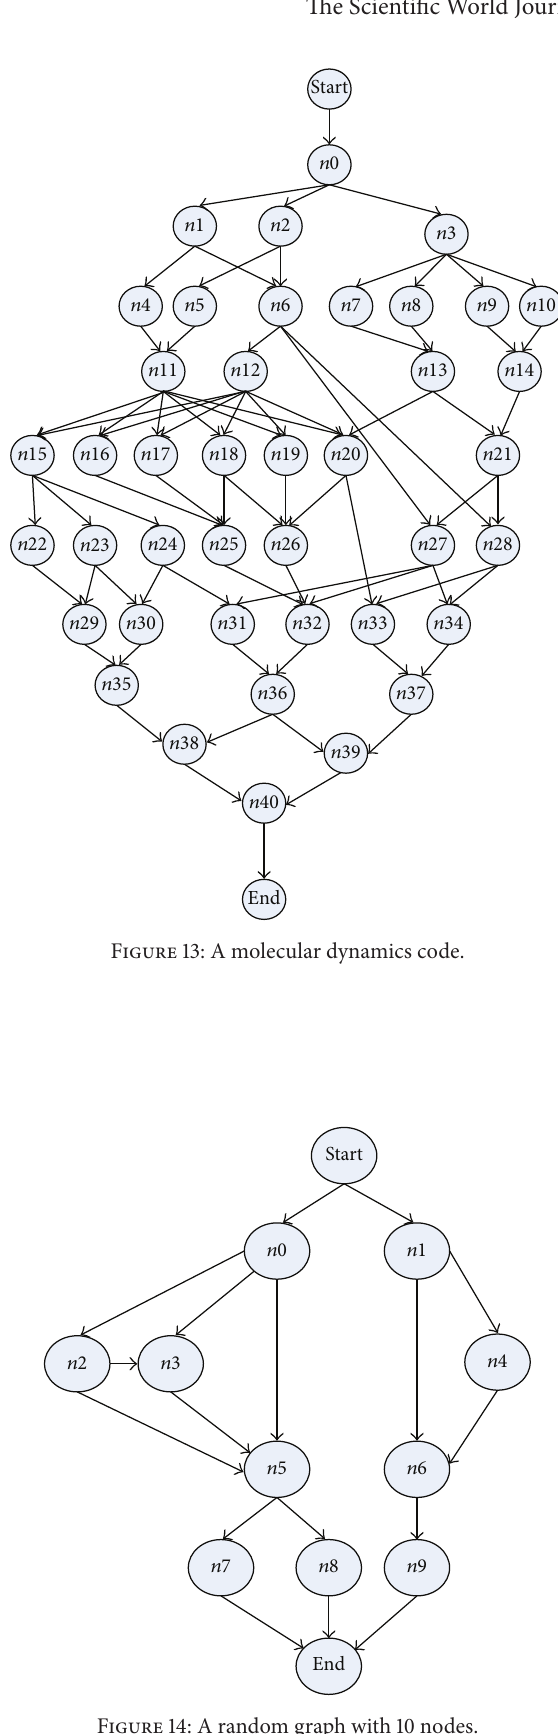
Figure 14: A random graph with 10